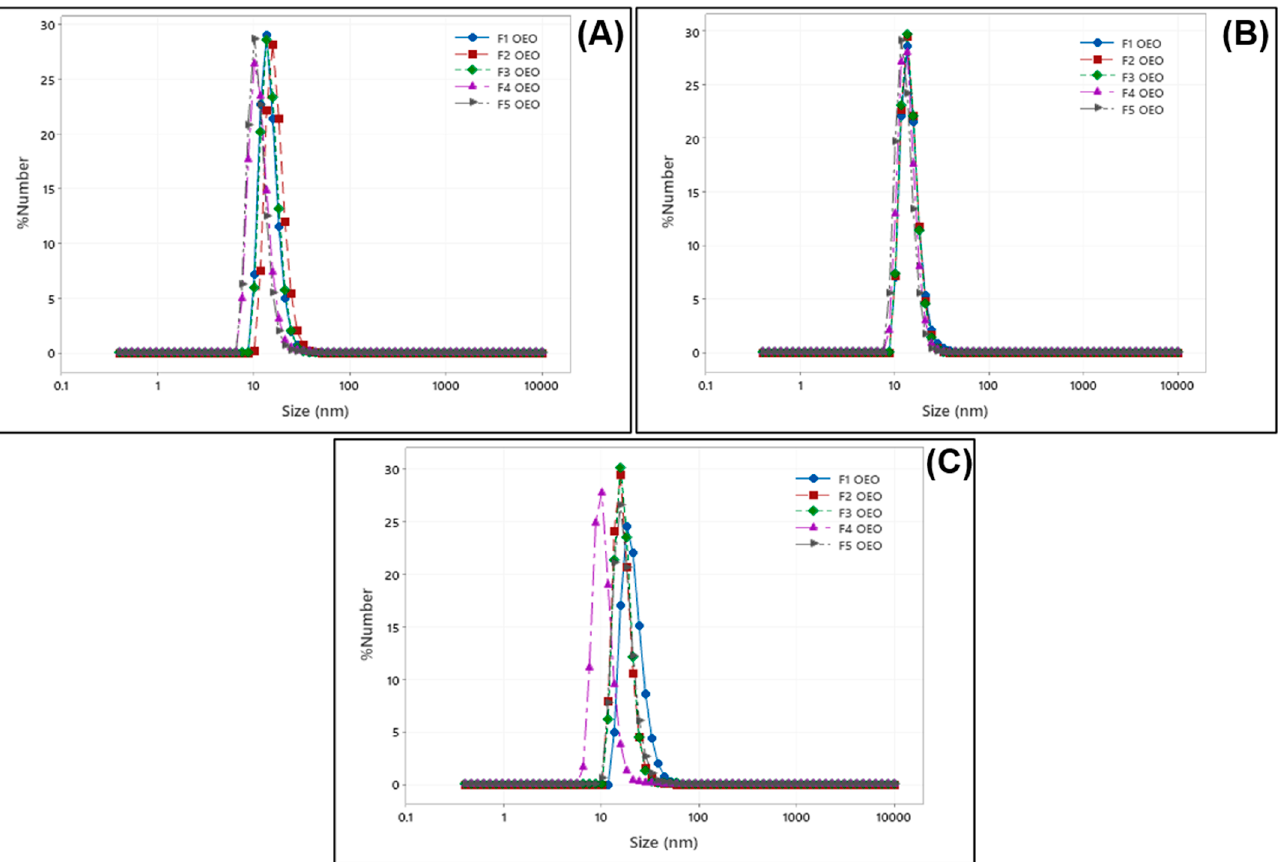
Figure 1. Average particle size distribution of OEO nanoliposomes ( A ) after 1 day of preparation, ( B ), after 1 week of preparation, and ( C ) after 1 month of preparation.